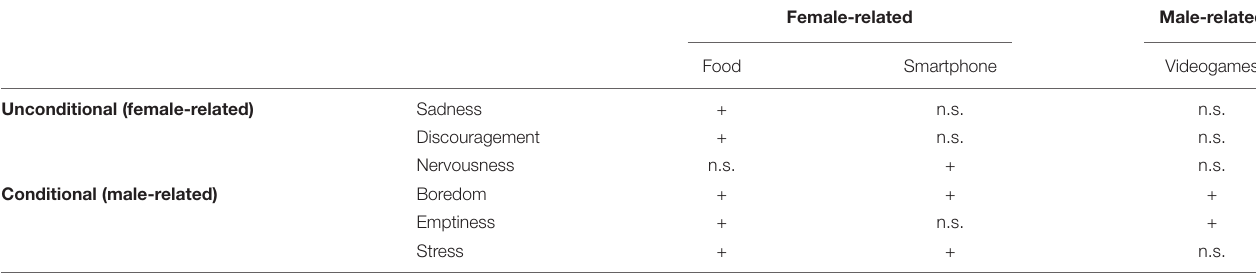
TABLE 7 | Impact of negative emotions on potentially addictive behaviors, disentangled by gender-related emotion, and gender-related non-creative